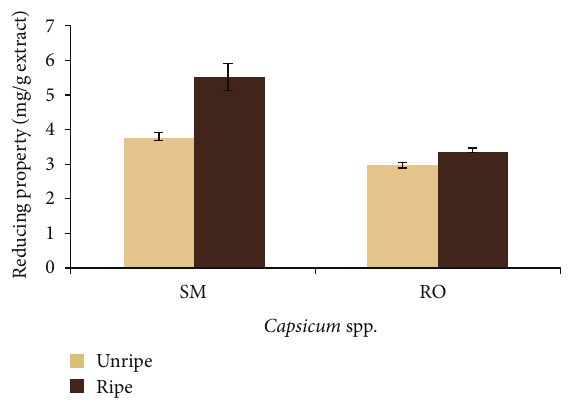
Figure 2: Ascorbic acid equivalent Ferric reducing property of aqueous extracts of Capsicum spp. SM: Capsicum annuum var. accu- minatum . RO: Capsicum chinense .